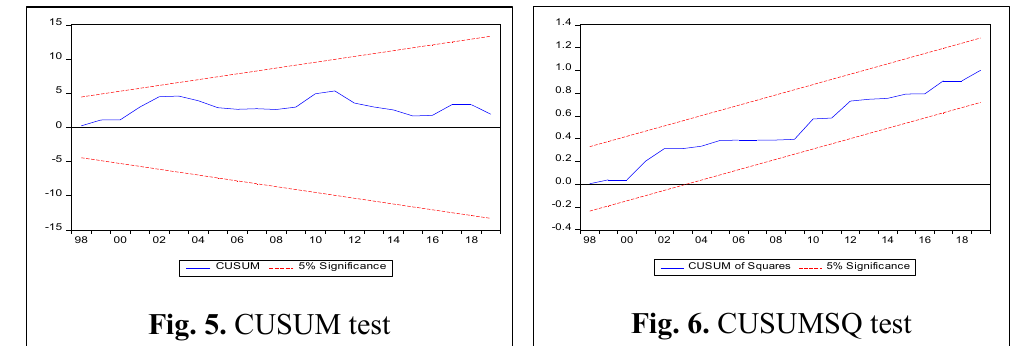
Fig. 5. CUSUM test Fig. 6. CUSUMSQ Fig. 5. Cumulative sum. Fig. 6. Cumulative sum of squares.